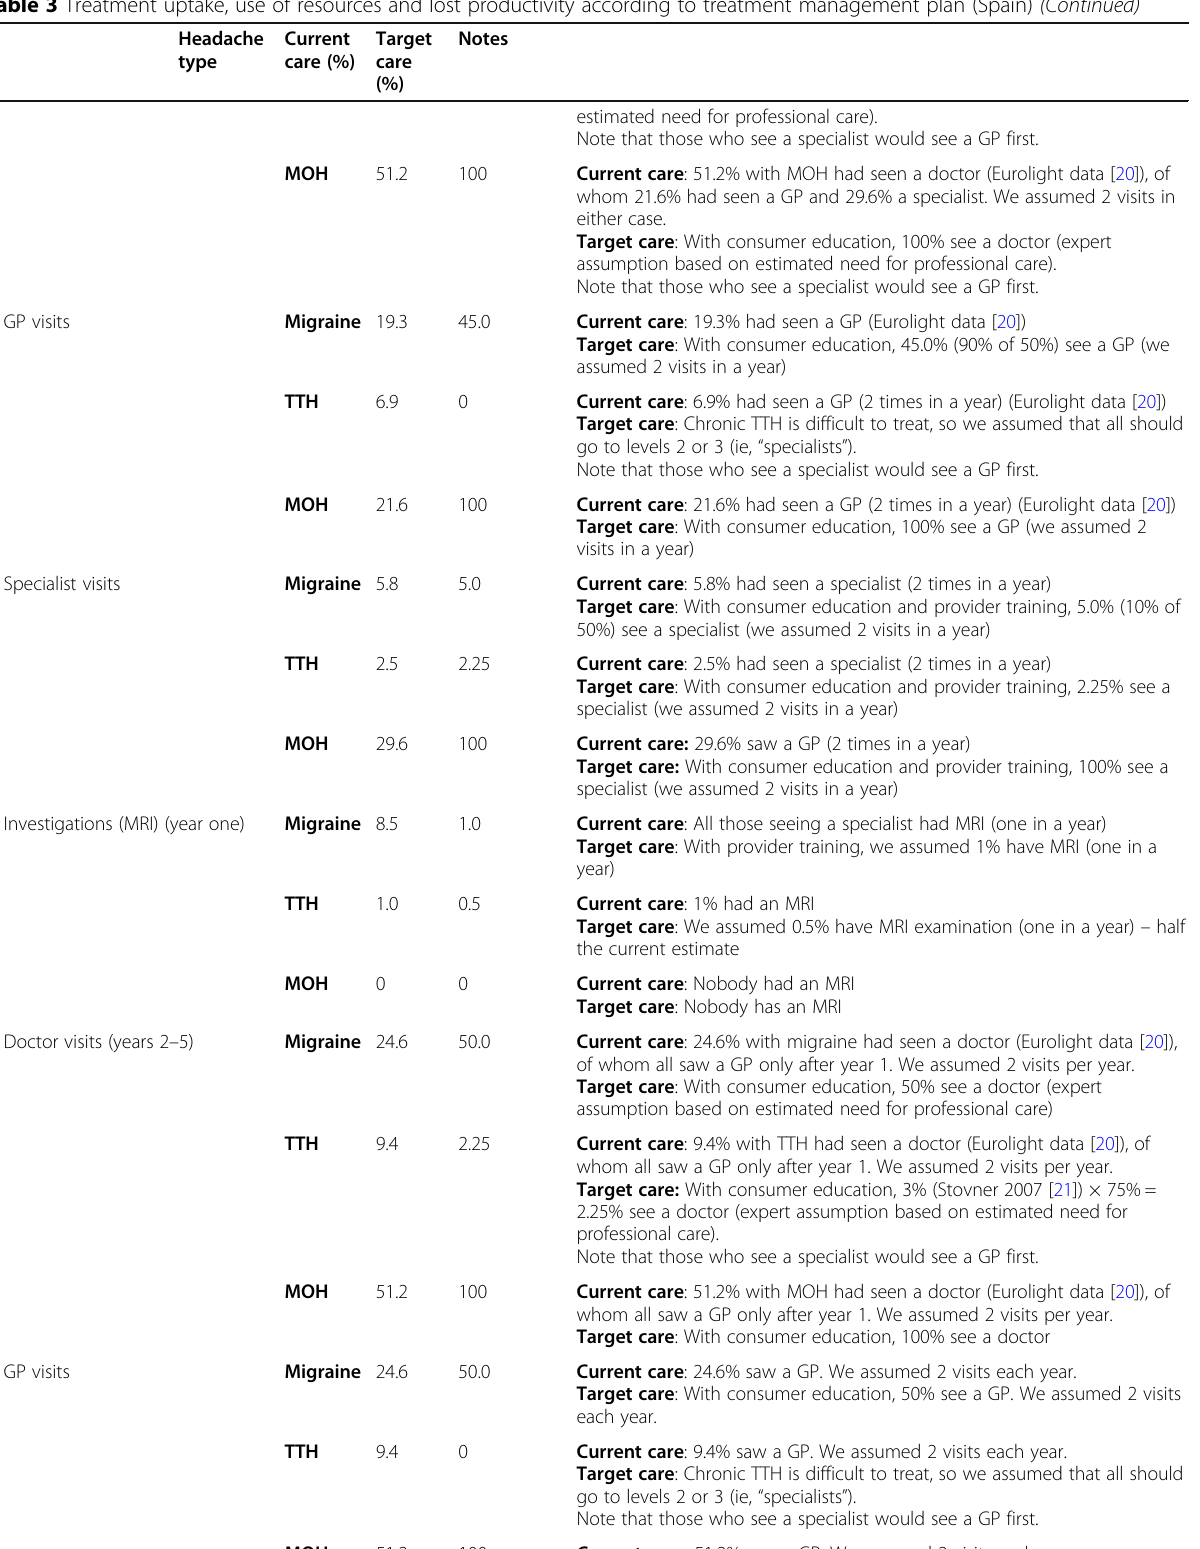
Table 3 Treatment uptake, use of resources and lost productivity according to treatment management plan (Spain)